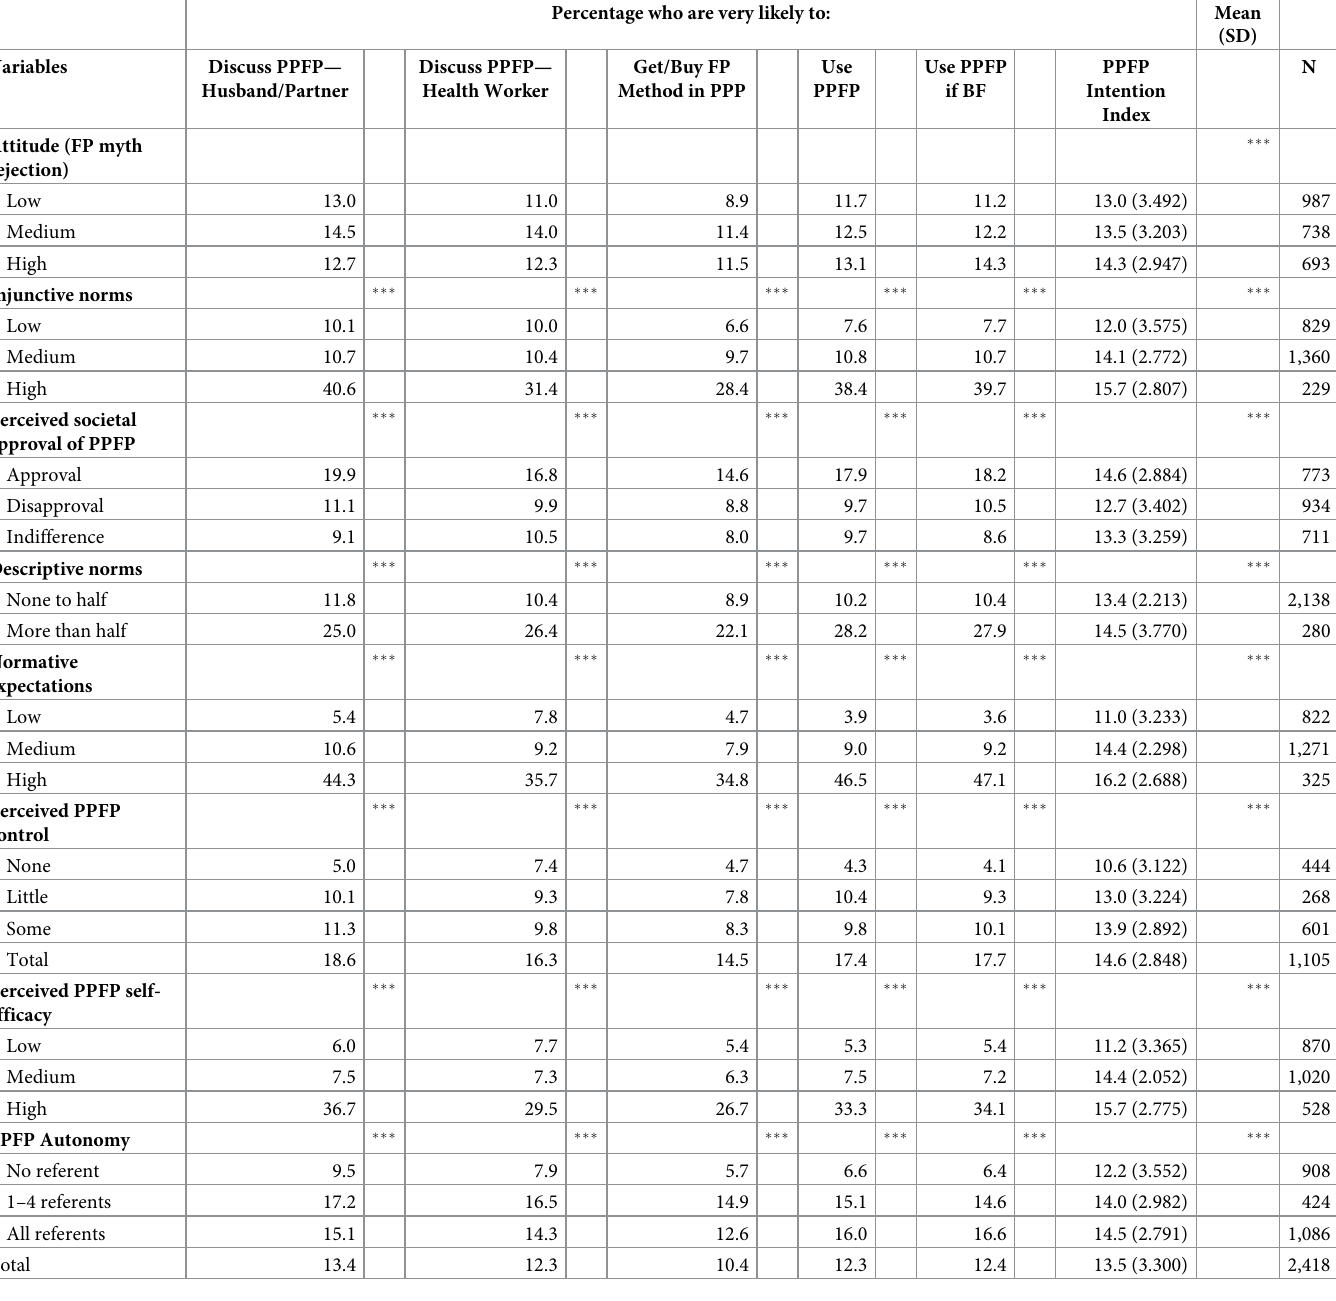
Table 3. Percentage of first-time mothers age 15–24 who stated they were very likely to have specific postpartum family planning intentions and the mean intention index by age group and selected variables, Kinshasa